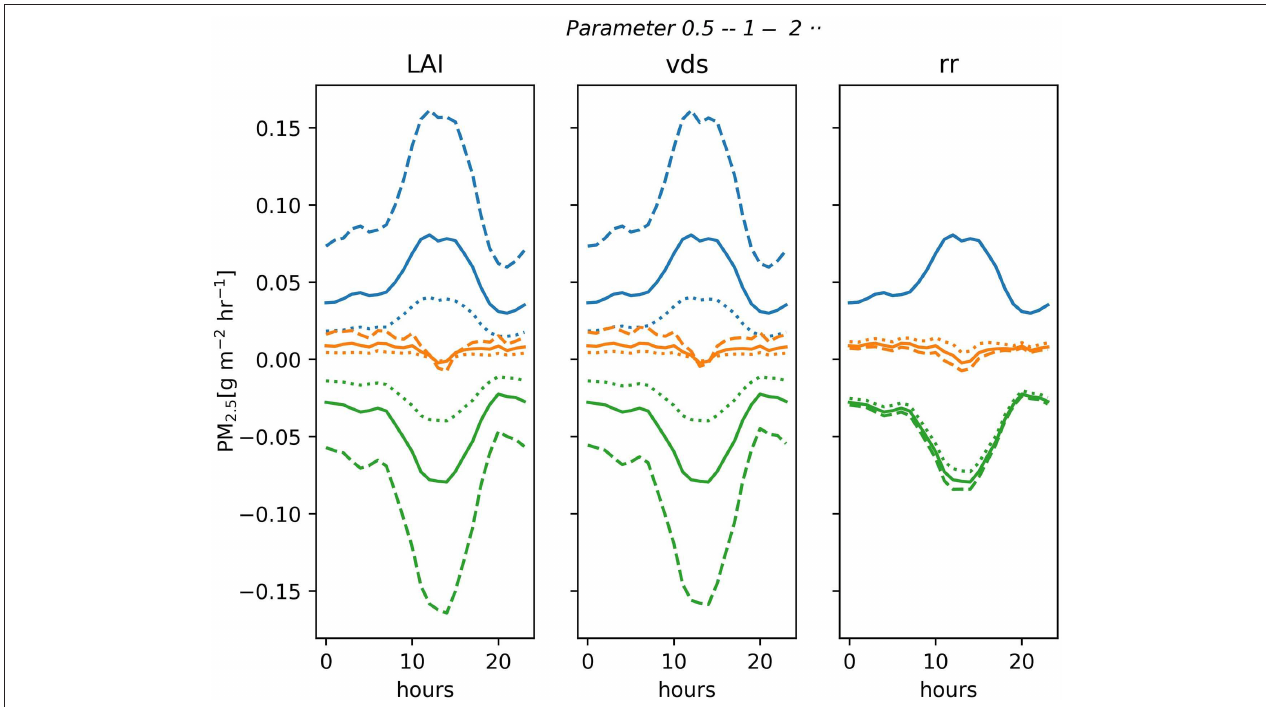
FIGURE 4 | Sensitivity of deposition (blue lines), net removal (orange), and resuspension (green) to parameter changes of leaf area index (LAI, left), specific deposition velocity (vds, middle), and resuspension percentages (rr, right). All simulations were run with half, normal and double values relative to standard parameters in the i-Tree Eco model (LAI: 3; vds: 0.2; rr see Tables S1 , S2 ). All simulations are carried out for Rome in 2014 (DOY 221-263) and 2015 (DOY 133-154; 177-224; 267-279) and presented as the average diurnal